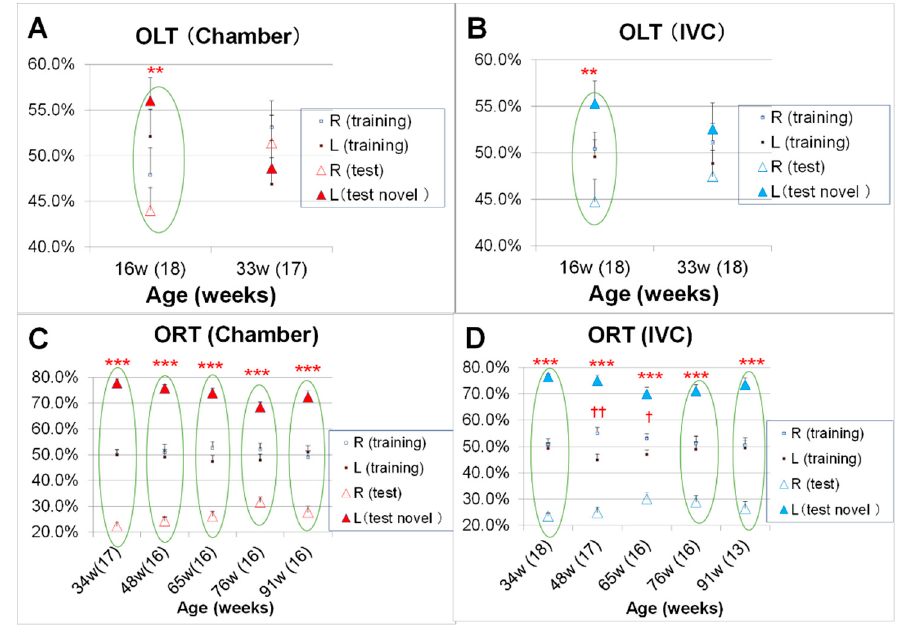
Figure 10. Changes in cognitive functions with aging in object location test (OLT, Test 8) and object recognition test (ORT; Test 9) in the chamber and IVC groups: ORT: ( A ) chamber group, ( B ) IVC group, ORT; ( C ) chamber group, ( D ) IVC group. Comparison of recognition index in terms of location of the familiar object (OLT) and the novel object (ORT) during the test phase using the unpaired t-test., *** p < 0.001; ** p < 0.01 by t-test. Between-group comparisons in the training phase, †† p < 0.01; † p < 0.05 by t-test.